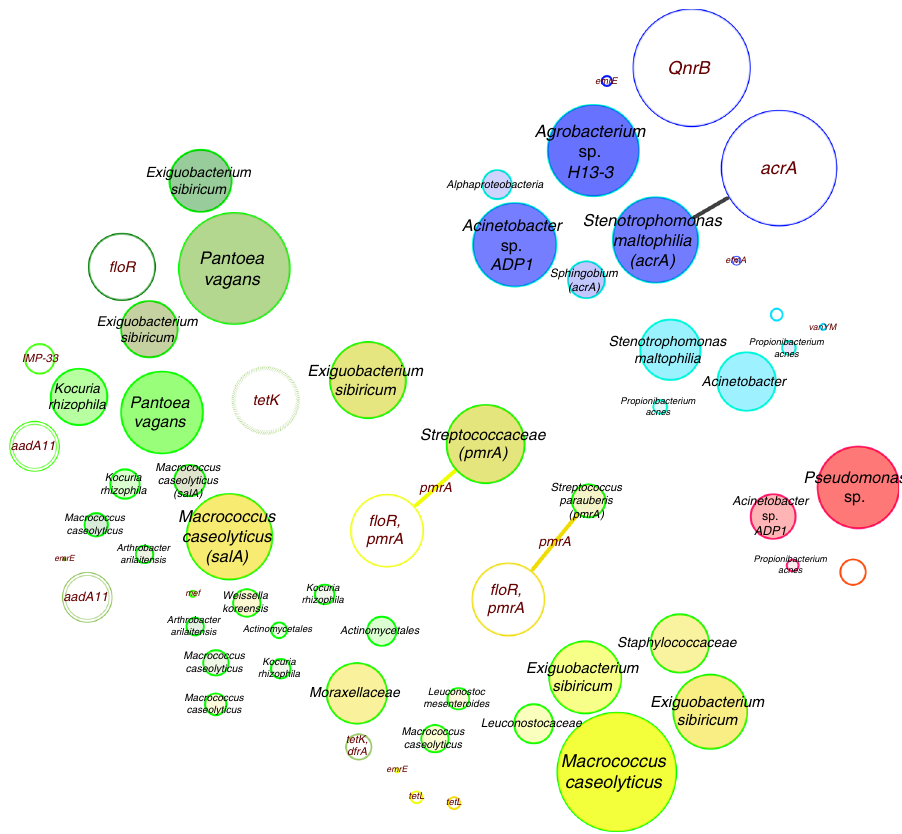
Fig. 6 Resistance network of genomes and plasmids. Potentially transferred (edge-connected) resistance genes (CARD database) according to their presence/absence in binned genomes and plasmids inside the same built environment. Edge-weighted spring-embedded algorithms implemented in Cytoscape were used for visualizations. Filled circles represent genomes and empty circles, plasmids. Most abundant resistance genes were used for labeling and correlated to circle sizes. Colors are de fi ned by respective built environments: blue (cleanroom facility); red (intensive care unit); dark green (public buildings); light green (public houses); yellow (private houses). CARD, Comprehensive Antibiotic Resistance